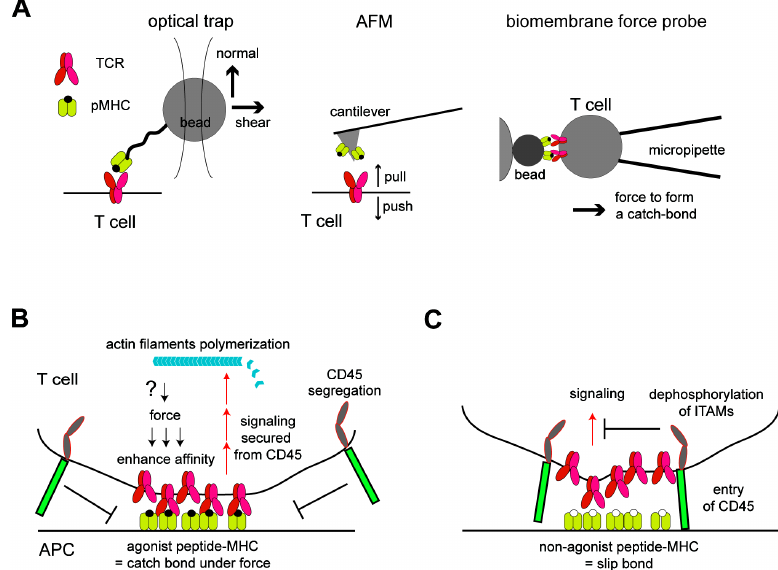
Figure 2. Mechanical regulations of TCR activation. ( A ) Biophysical assays to probe the mechanical regulations of TCR. Either an optical trap, atomic force microscope (AFM), or biomembrane force probe can load and measure the force in the binding between the TCR and pMHC. T cell activation can be measured simultaneously by imaging the calcium flux. ( B ) Roles of force in T cell triggering induced by ligation to the agonist peptide MHC. Force generated at the membrane interface enhances the affinity between TCR and pMHC by forming a catch bond, resulting in the formation of a tight membrane–membrane junction. These junctions spatially exclude CD45 by blocking the entry of the bulky and highly glycosylated extracellular domain of CD45 in this confined space. In this geometry, the signaling stemming from phosphorylated ITAMs in the TCR can be more active by securing it from the tyrosine dephosphorylation by CD45. The signaling leads to local actin nucleation, which likely functions to load forces on the TCR. ( C ) Such a feedback loop is not generated in the binding between the TCR and nonagonist peptide MHC, which only forms a slip bond. The binding of these two molecules remains a lower affinity, and the junction between these cells cannot be tight enough to exclude CD45. The entry of CD45 blocks the signaling from the TCR to downstream by dephosphorylating ITAMs in the TCR.